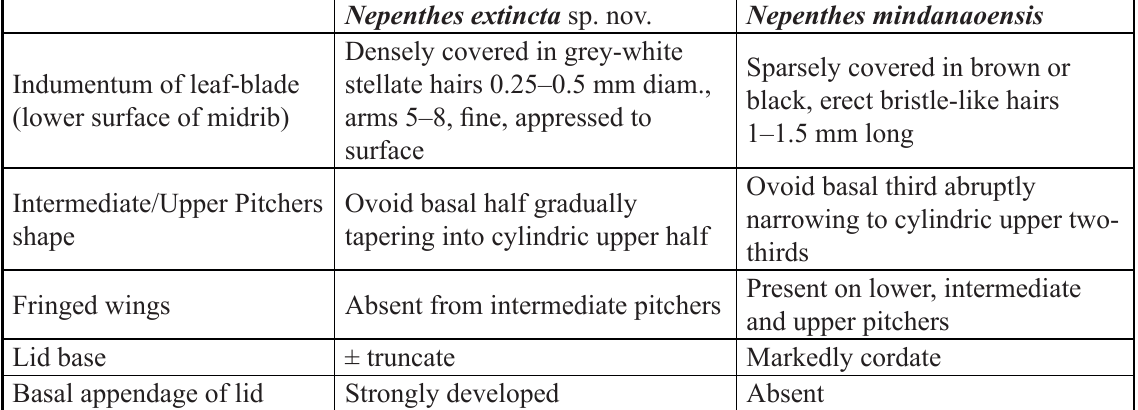
Table 3. Diagnostic characters separating N. extincta sp. nov. from N. mindanaoensis